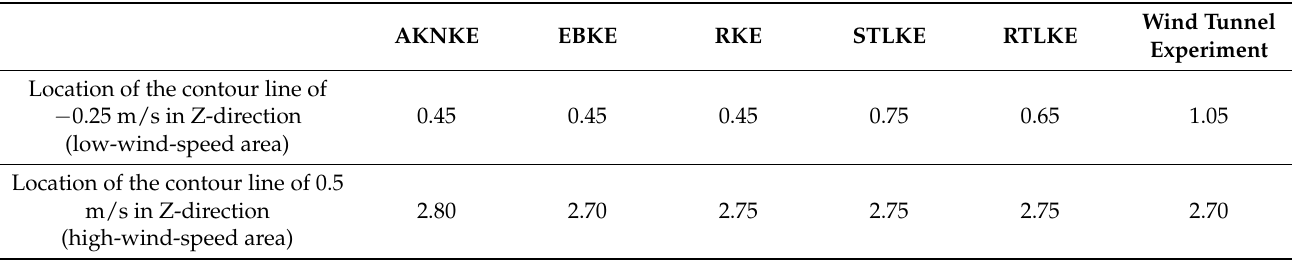
Table 5. Location of contour line at Y = 0 ( W